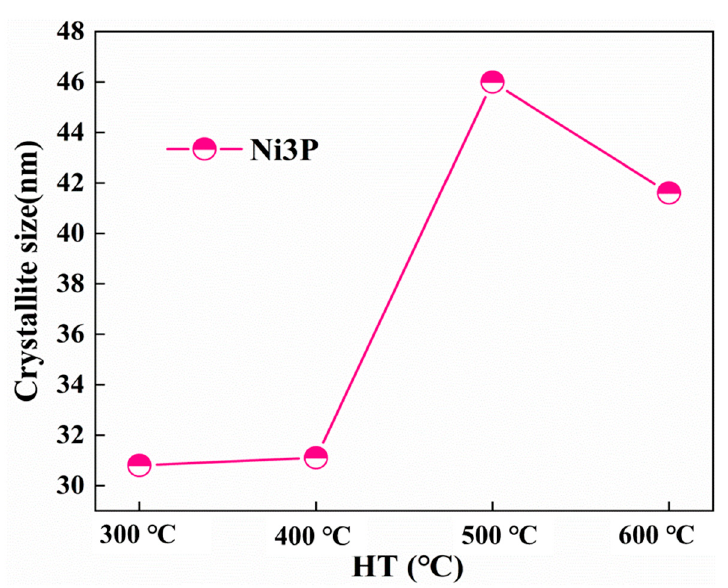
Figure 8. Crystallite size of Ni3P.